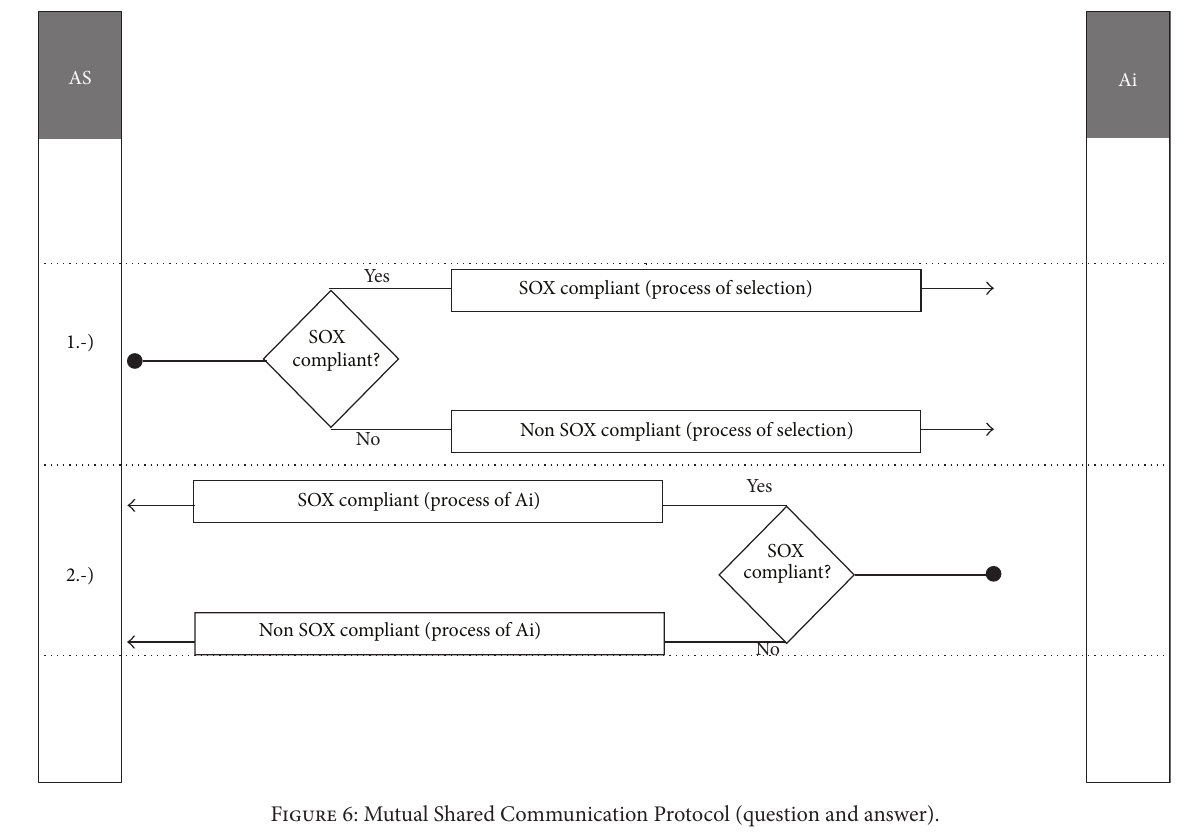
Figure 6: Mutual Shared Communication Protocol (question and answer).